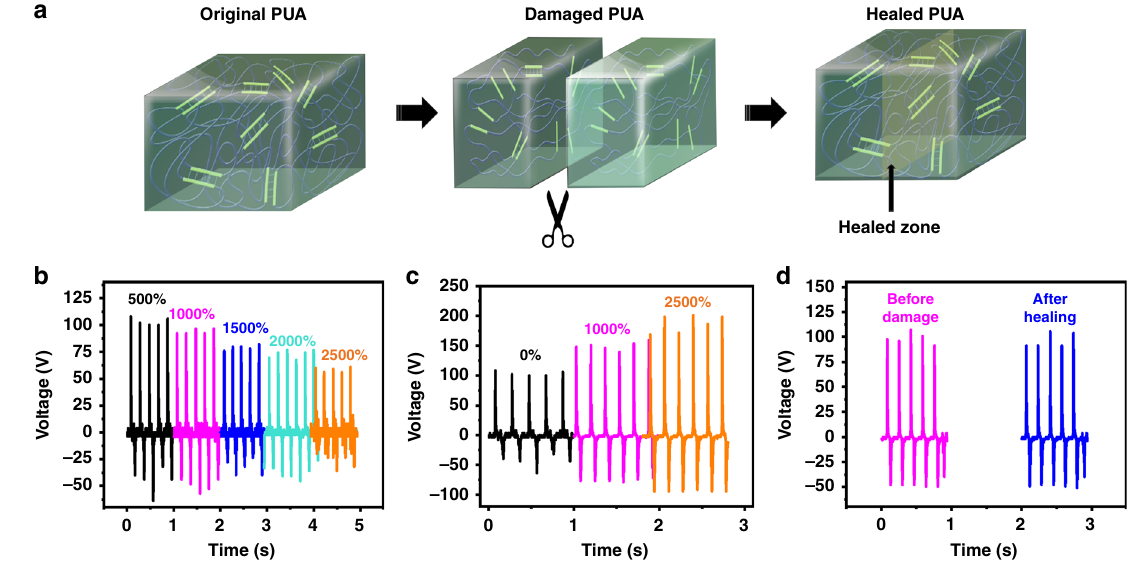
Fig. 4 Illustration of self-healing of polyurethane acrylate and energy-harvesting performance. a Schematic illustration of the healing of the polyurethane acrylate (PUA) conductor via breaking and reforming of hydrogen bonding. b The output voltage of the stretchable and healable triboelectric nanogenerator (SH-TENG) subjected to an impact of 40 N at a frequency of 5 Hz under various uniaxial strains. The measurements were carried out by straining the PUA layer of the SH-TENG device, while the area of the impacting force (area of the top latex layer, 3 × 3 cm 2 ) was kept constant. c The output voltage of the SH-TENG subjected to an impact of 40 N at a frequency of 5 Hz under various uniaxial strains, when the area of the latex is increased so that it was similar to the uniaxial strain of the device. d Output voltage of the SH-TENG before mechanical damage and after